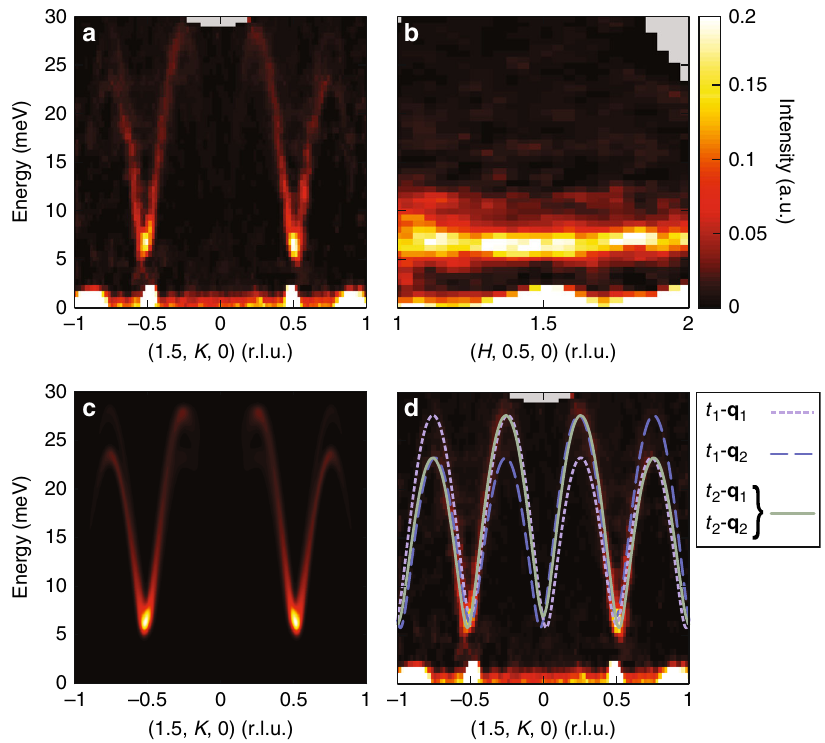
Fig. 2 Magnon spectra at T = 2.5 K collected via time-of- fl ight neutron scattering measurements. a Dispersion of magnons along the chain axis ( K - direction) across the full bandwidth of excitations. Data were integrated across − 0.1 to 0.1 along L and from 1.4 to 1.6 along H . b Dispersion along the interchain axis ( H -direction) with data integrated from − 0.1 to 0.1 along L and from 0.48 to 0.52 along K . c Simulated scattering intensities using the model fi t to the data described in the main text and integrated over the same values as a . d Fit transverse modes from the four allowed domains generating the spectral weight in c and then overplotted with the raw data from low temperature, ordered spin lattice of α -NaMnO 2 onto the ab - plane where one spin domain with propagation vector q 1 = (0.5, 0.5, 0) is illustrated. The antiferromagnetic chain direction is shaded in gray. Due to the degeneracy of the frustrated interchain coupling, a second spin domain with propagation vector q 2 = ( − 0.5, 0.5, 0) also stabilizes, and the moments in both domains are oriented approximately along the [ − 1, 0, 1] apical oxygen bond direction due to an inherent uniaxial single-ion aniso- tropy 11 . The large Jahn – Teller distortion renders the lattice structure prone to crystallographic twinning 16 and the relative orientations of the moments in the two resulting crystallographic twins, twin 1 ( t 1 ) and twin 2 ( t 2 ) are depicted in Fig. 1b. This